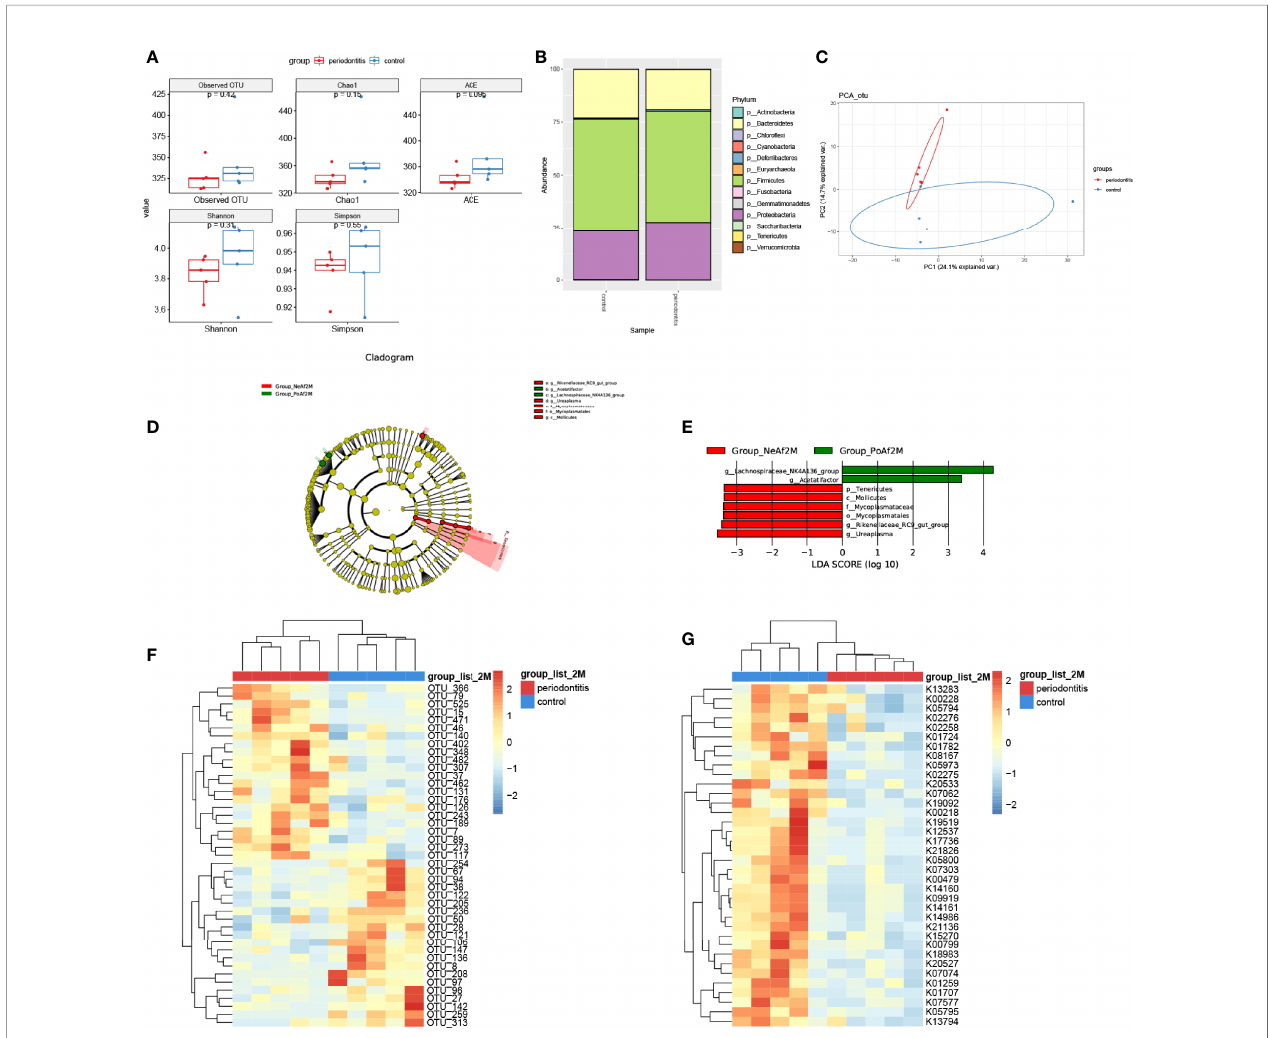
FIGURE 2 | Gut microbiota alternation in periodontitis mouse model. (A) boxplot showed the value of the indicated index of alpha diversity of the periodontitis group and control group after 2-month treatment of P. gingivalis . (B) stack bar plot, showed the composition of microbiota at phylum level. (C) PCA plot of microbial composition. (D) linear discriminant analysis effect size (LEfSe)-based cladogram of fecal samples. (E) LDA scores of fecal samples. (F) Heatmap of sequenced bacterial operational taxonomic unit (OTU) abundances, scaled by row. (G) Heatmap of KEGG KO ORTHOLOGY analyzed by Tax4Fun2, scaled by row. 2M = 2 months after administration. The taxon name is preceded by one of the following: p_, phylum; f_, family; g_, genus; s_, species. Data are presented as mean ± SEM. (n =